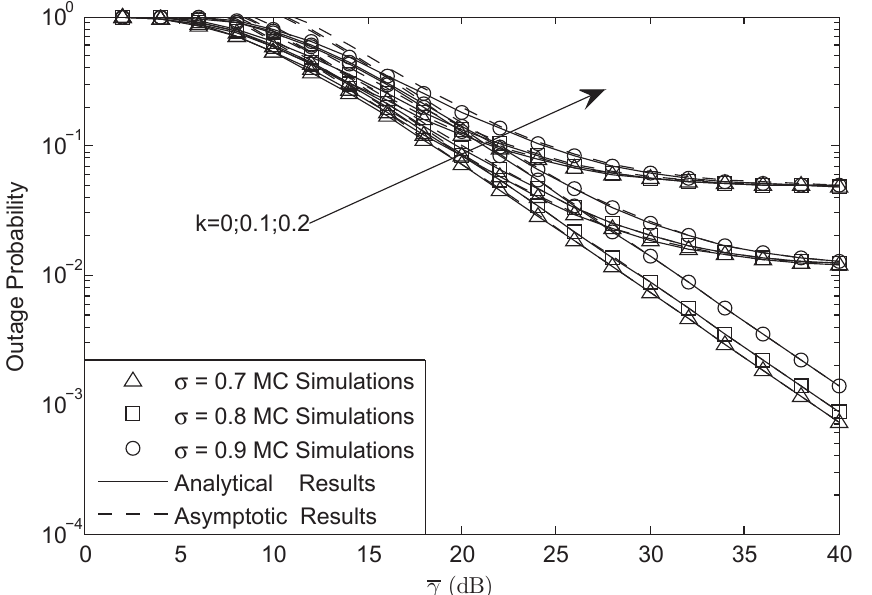
Figure 3. OP of the system versus different γ with M = 1, L = 10 and γ 0 = 3 dB: